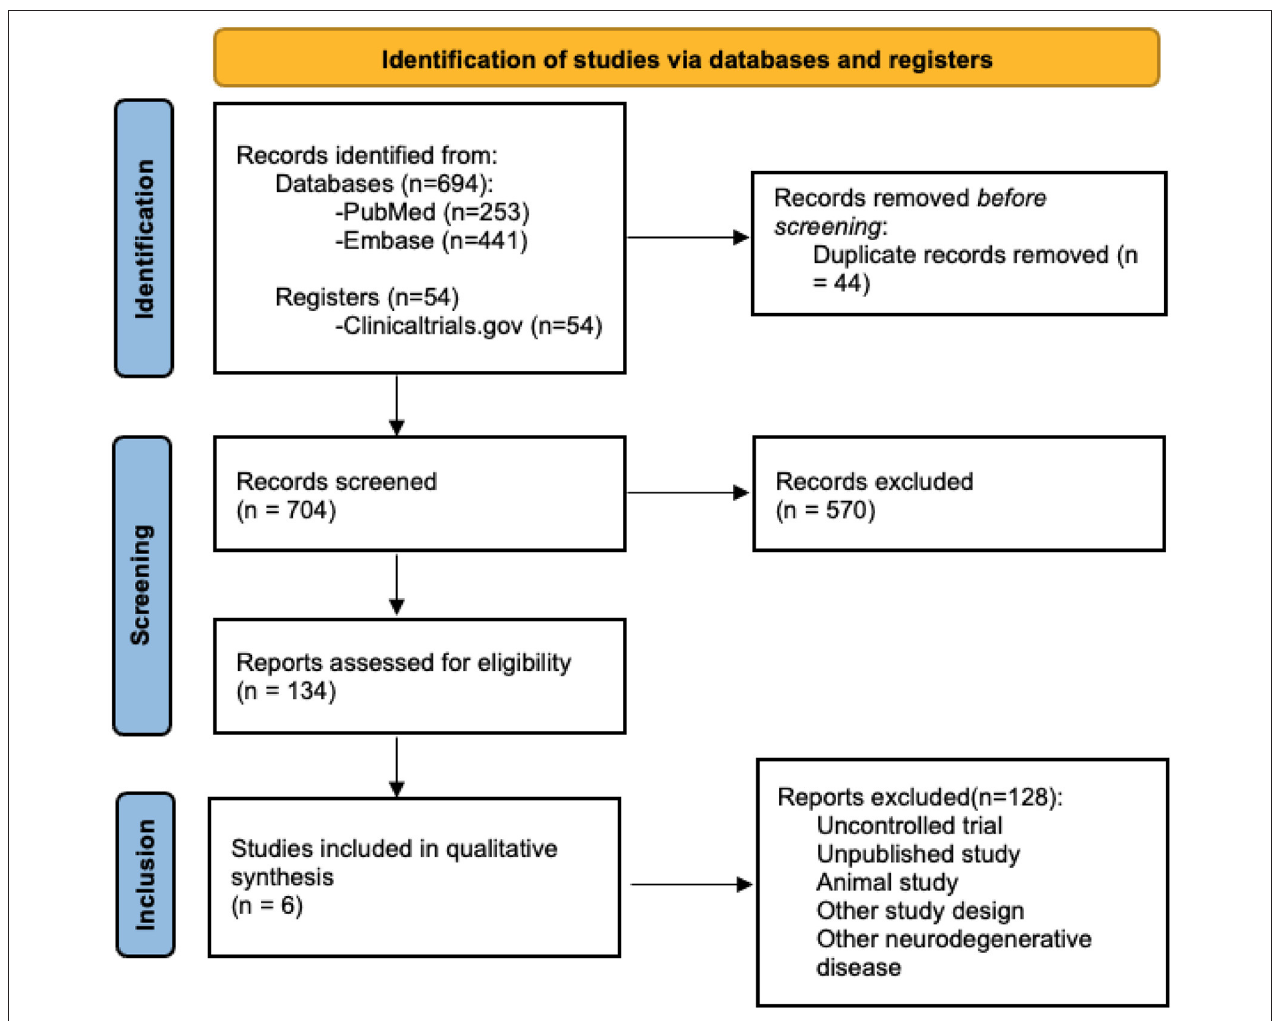
FIGURE 1 | PRISMA for included